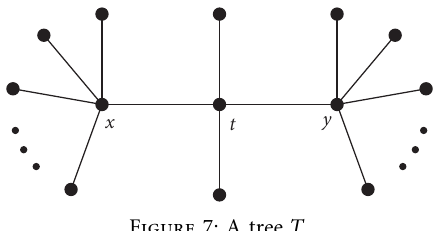
Figure 7: A tree T